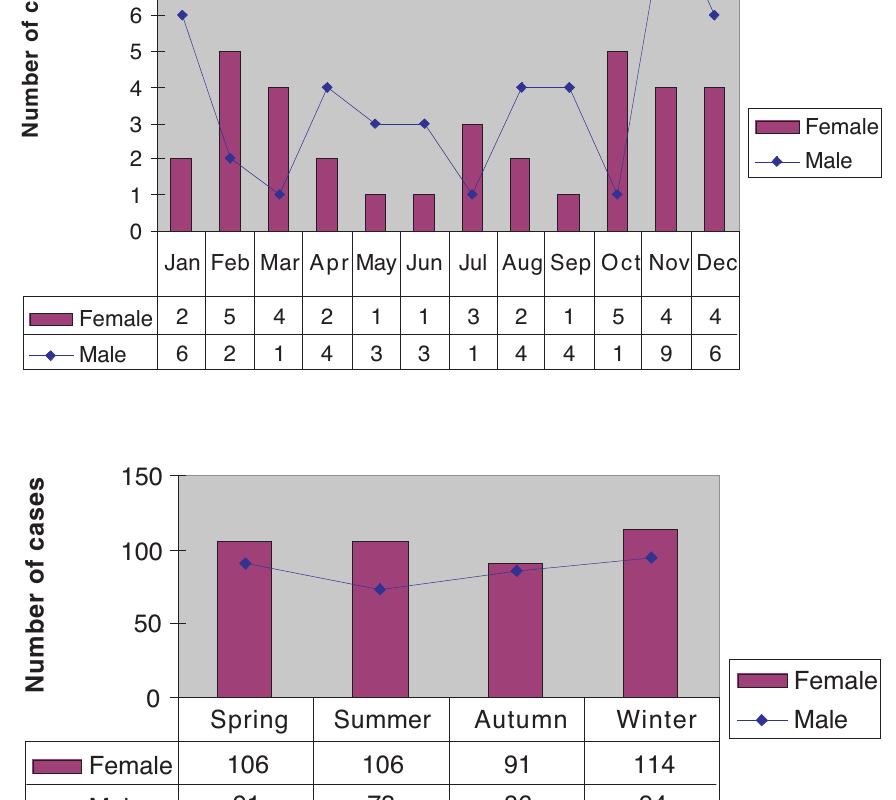
Figure 3 The distribution of AVM cases according to sex and months (p = 0.175; p >0.05).